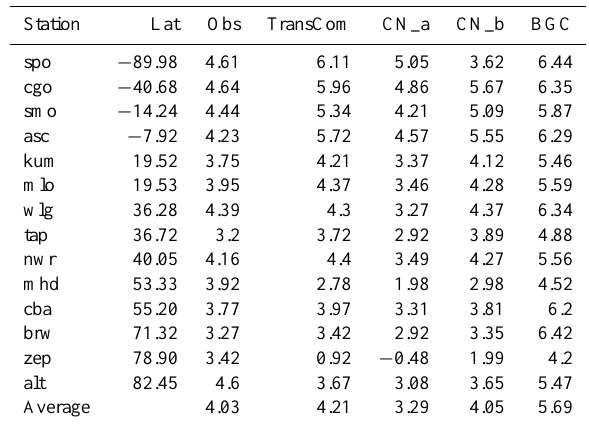
Table 3. Comparison of the mean growth rate (ppbyr − 1 ) of at- mospheric methane concentration in each simulation with observa- tions. Station